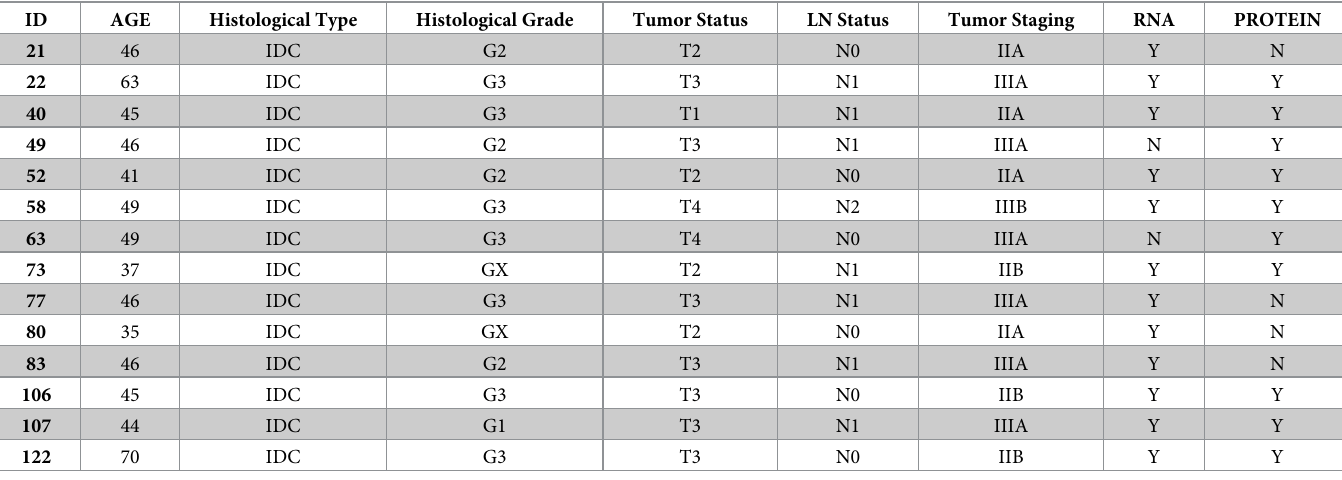
Table 4. Trastuzumab-treated HER2+/ER+ tumors h